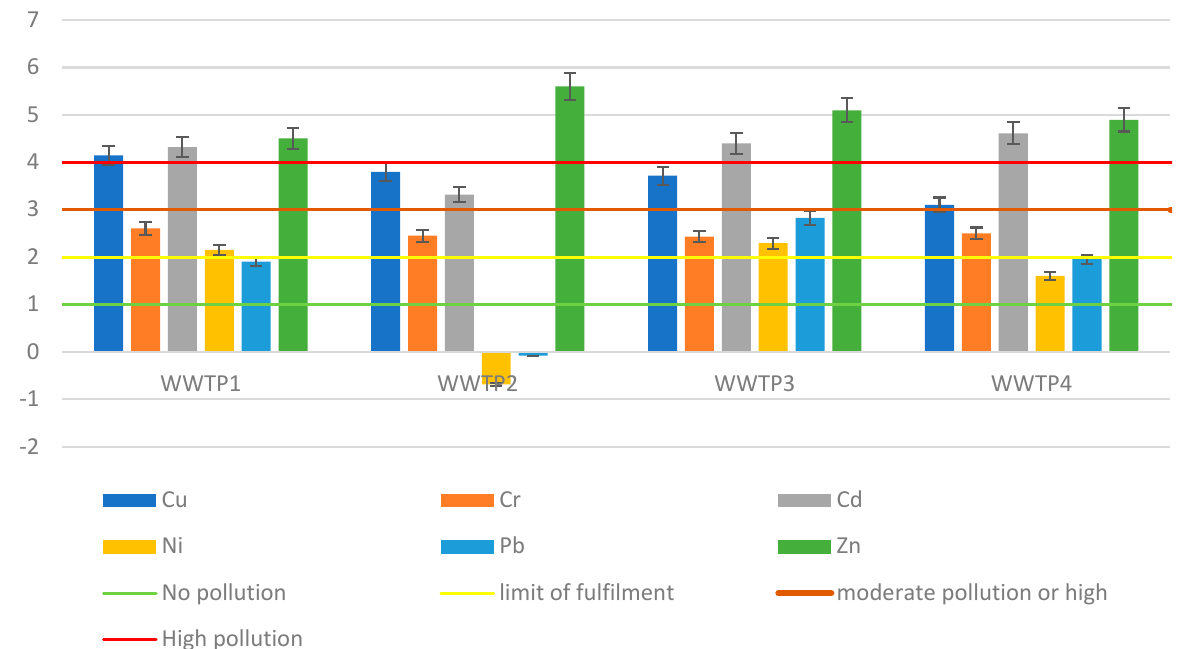
Figure 2. The geoaccumulation index (Igeo) of heavy metals in sewage sludge. For all analyzed cases of sewage sludge, the RAC showed no high risk of environ- mental contamination. This is due to the low content of heavy metals in the FI fraction. Statistically, sediments collected from WWTP4 have the highest percentage of metals in the FI fraction. The highest percentage was recorded for cadmium from WWTP4, which was 25%, but it did not reach the high-risk level. The outcomes can be considered satisfactory; however, it should be noted that the RAC index only considers the FI fraction, ignoring the heavy metals in the FII and FIII fractions. Figure 3 shows the RAC value for all sewage sludge samples.